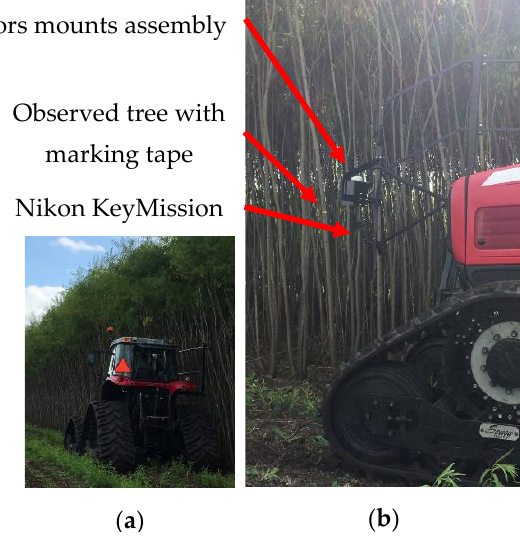
Figure 7. ( a ) Final field trials; ( b ) sensing components layout.